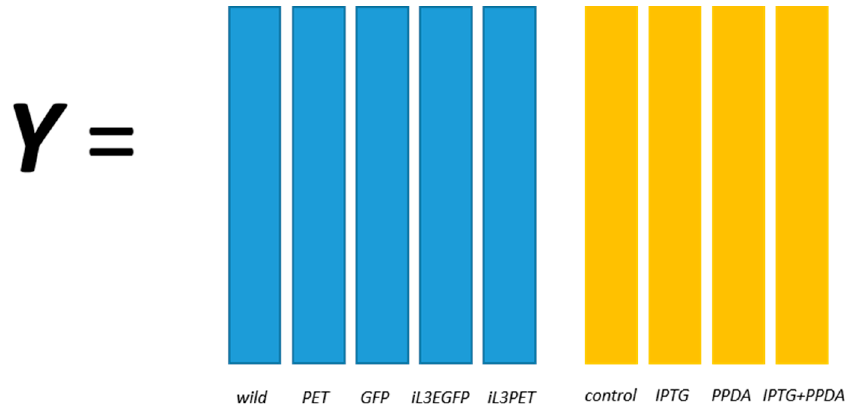
Figure 1. Structured output coding for the riboswitch set; for example, a wild-type sample under the IPTG inducer condition would be coded as [1 0 0 0 0 0 1 0 0].